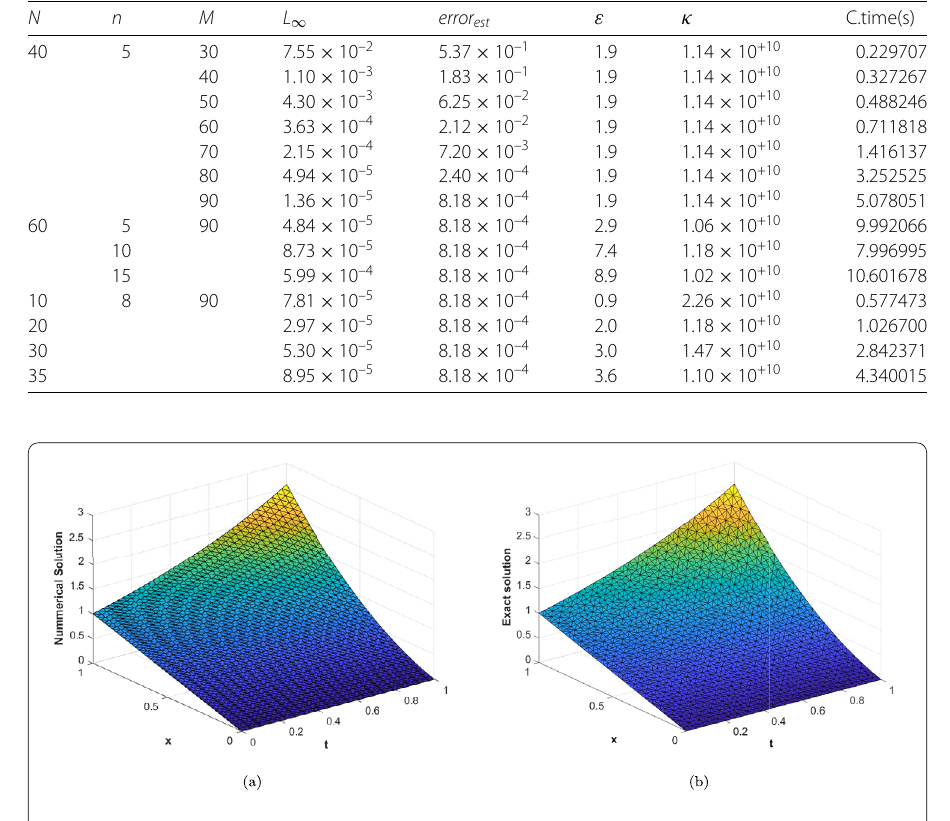
Table 1 The results are obtained for α = 0.22111, x ∈ [0,1], and t =